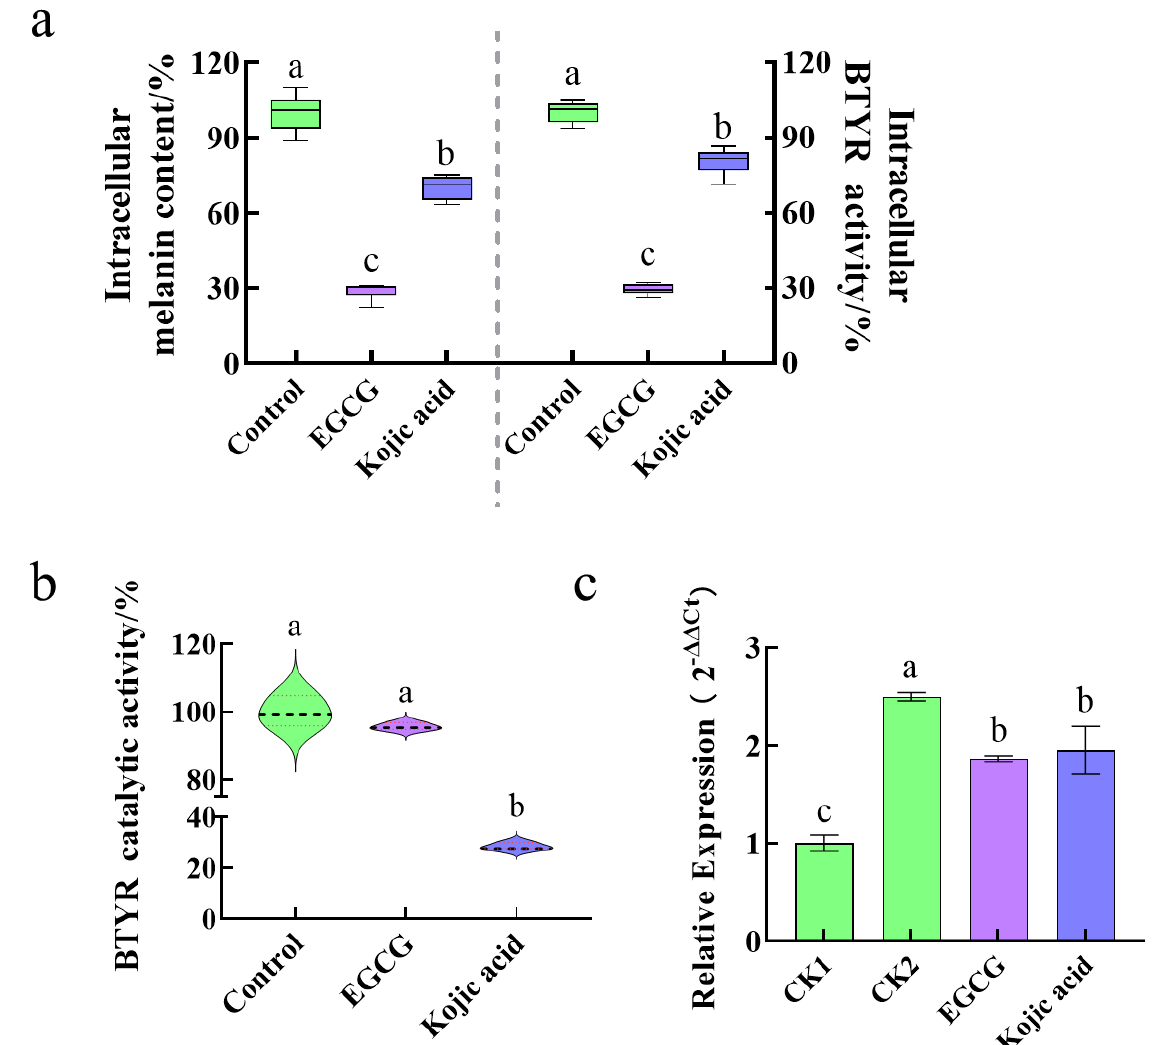
Figure 4. The mechanism of 100 µg/mL EGCG and kojic acid on inhibiting BTYR activity. ( a ) Influence of EGCG and kojic acid on intracellular melanin content and BTYR activity. α -MSH stimulated B16F10 cells were cultured by complete medium containing compounds for 48 h. Then intracellular melanin content and BTYR activity were detected; ( b ) BTYR catalytic activity of EGCG and kojic acid. TYR extraction was followed by sample treatment. The reaction among BTYR, substrate and sample was conducted in non-cellular system; ( c ) Effect of EGCG and kojic acid on expression of BTYR mRNA. α -MSH stimulated B16F10 cells were cultured by complete medium containing compounds for 24 h. Then the expression of BTYR mRNA was detected. CK1 was medium alone-added group, while CK2 was α -MSH alone-stimulated group. a,b,c Different letters above the plots indicate significant differences ( p < 0.05).